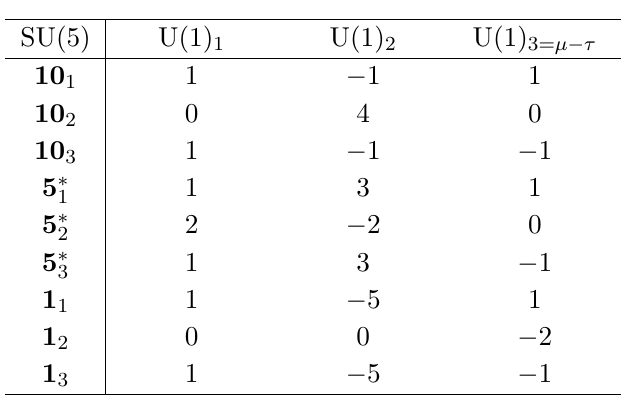
Table 3 . U(1) charges of the NG multiplets in breaking (3.3). The U(1) 1 , U(1) 2 and U(1) 3 are the unbroken U(1)’s of coset-subspaces E 7 /SO(10) × SU(2) × U(1), SO(10)/SU(5) × U(1) and SU(2)/U(1), respectively.